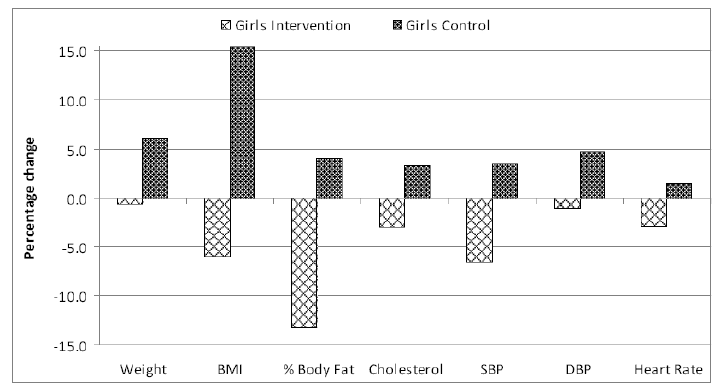
Figure 3. Changes in intervention and control pupils after 3 months: girls * .